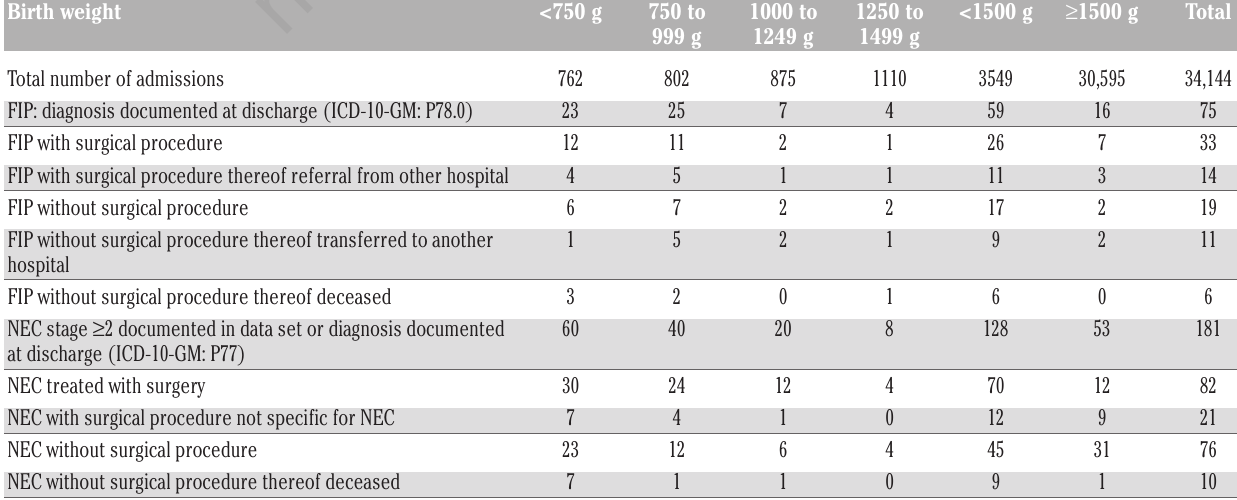
Table 1. Occurrence of neonatal focal intestinal perforation (FIP) and necrotizing enterocolitis (NEC) in hospitals in Baden- Württemberg during the years 2010 to 2012. Please note that the neonatal dataset does not allow combined patient follow-up after inter-hospital transfer; there may be both underreporting and overreporting of FIP and NEC (and related procedures). Birth weight <750 g Total number of admissions FIP: diagnosis documented at discharge (ICD-10-GM: P78.0)